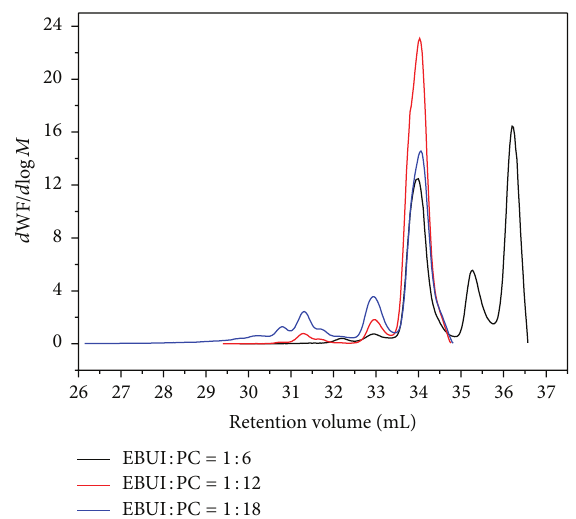
Figure 7: Molar mass distribution of the reaction products of EBUII with PC as a function of the retention volume.